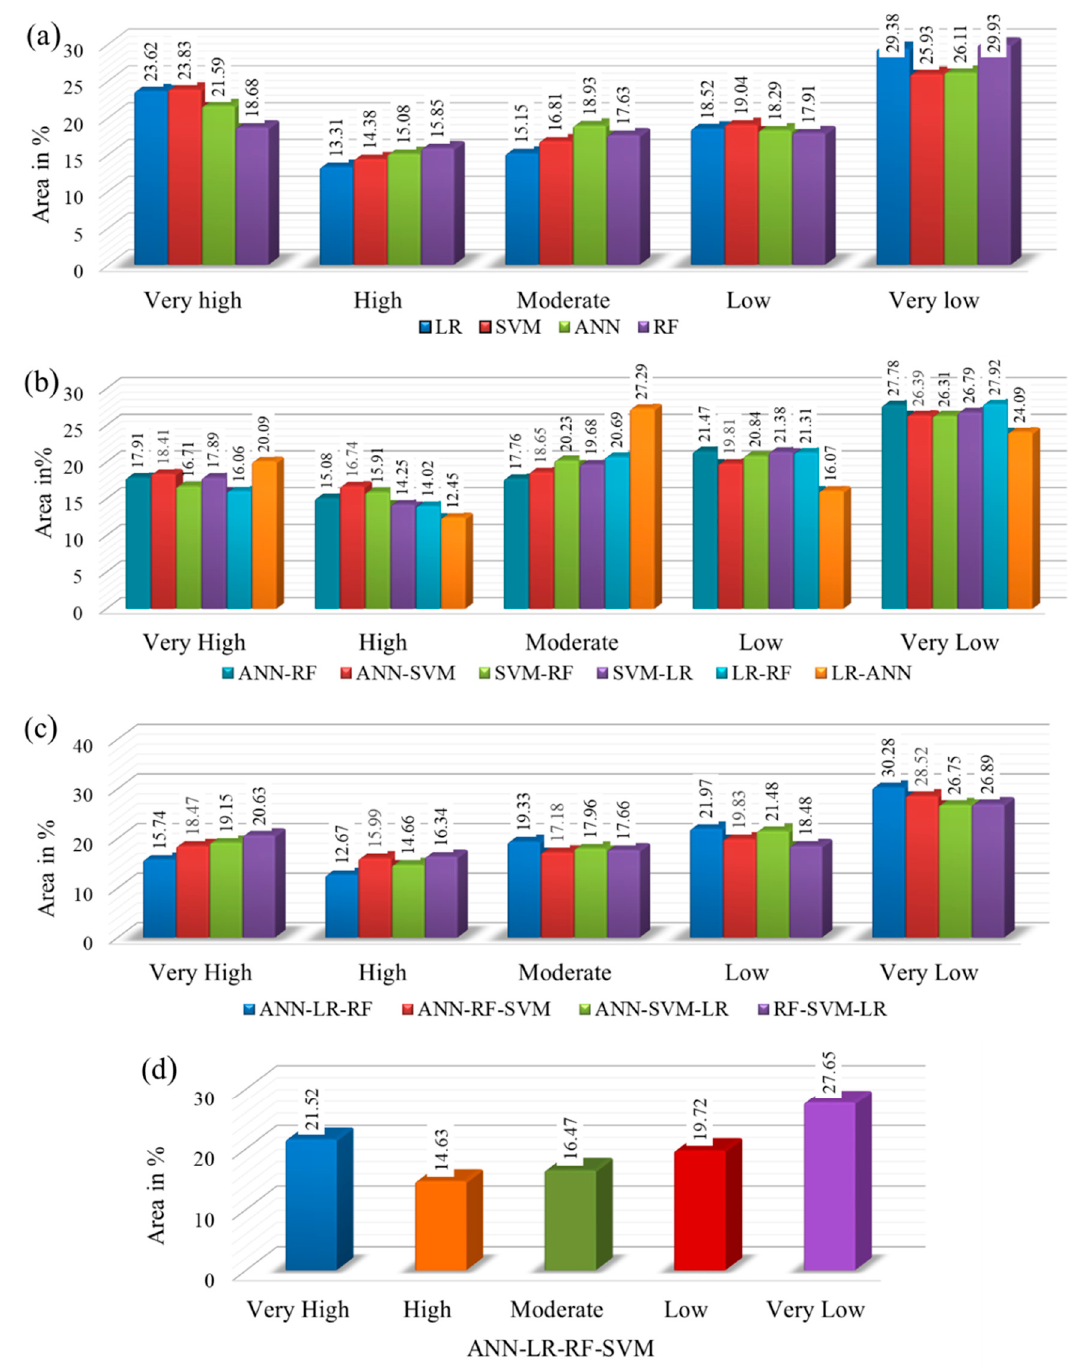
Figure 6. Distribution of area under different landslide susceptibility classes (in %) of ( a ) individual models, ( b ) ensemble of two models, ( c ) ensemble of three models and ( d ) ensemble of four models.